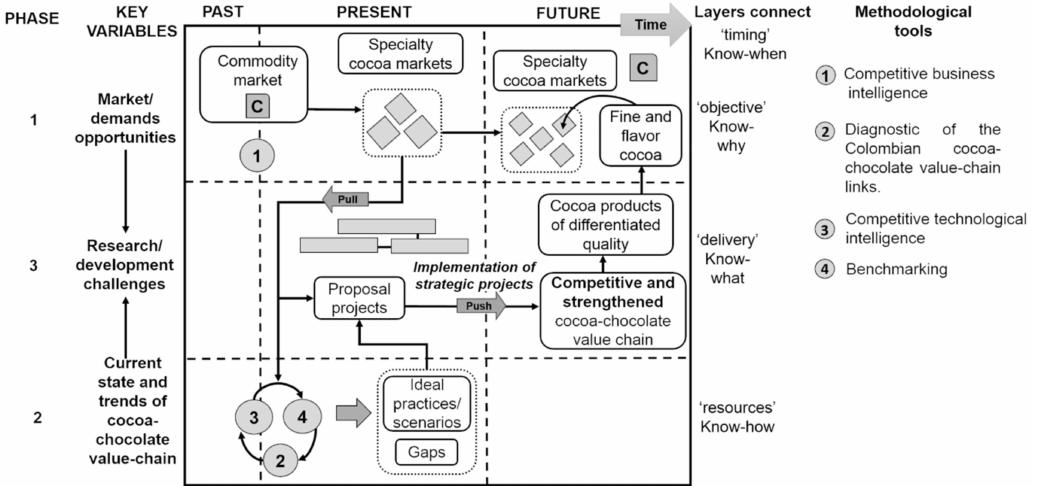
Figure 4. Methodological guide used to build the roadmap for the Colombian cocoa value chain: relationships between selected key components and time (adapted from Reference